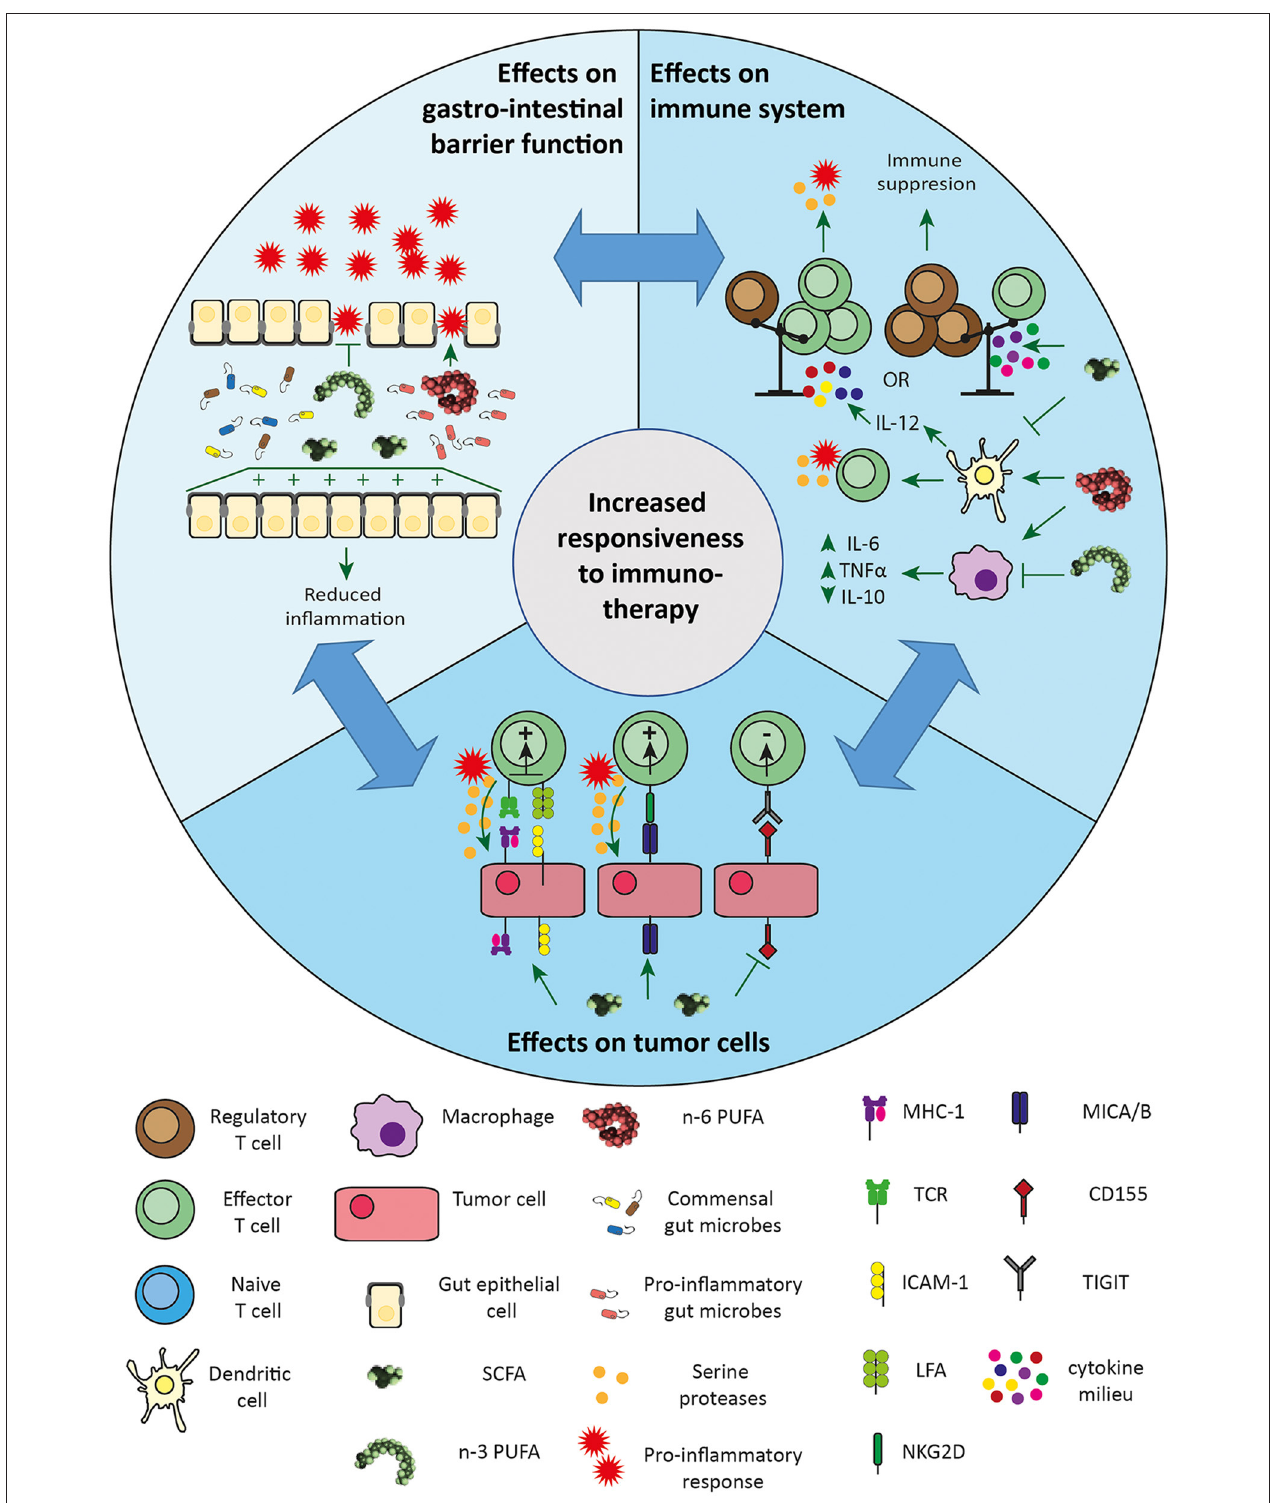
FIGURE 1 | Proposed mechanisms through which SCFAs and PUFAs enhance immunotherapy efficacy. Effects on gastric barrier: SCFAs can improve gut barrier function and have, as well as n -3 PUFAs, anti-inflammatory effects. Diets rich in n -3 PUFAs have a beneficial effect on the gut microbiome. Both have beneficial effects on gastro-intestinal functioning, thereby reducing immune-mediated toxicity and may enhance to immunotherapy outcome, as the need of cessation of treatment is lower. Diets rich in n -6 PUFAs lead to dysbiosis accompanied with pro-inflammatory effects. Effects on immune system: SCFAs promote T cell differentiation in